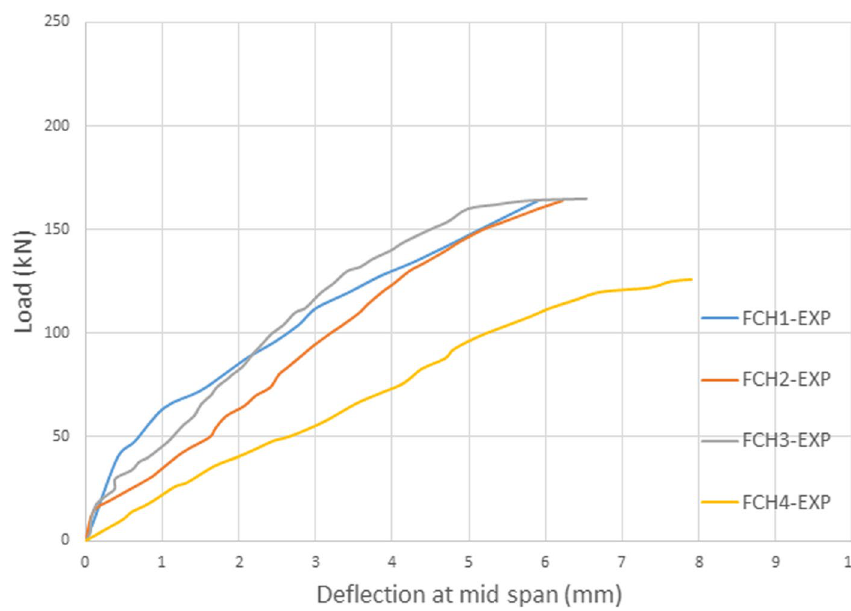
Fig. 18 Load vs. mid-span deflection curves for FCH1, FCH2, FCH3, and